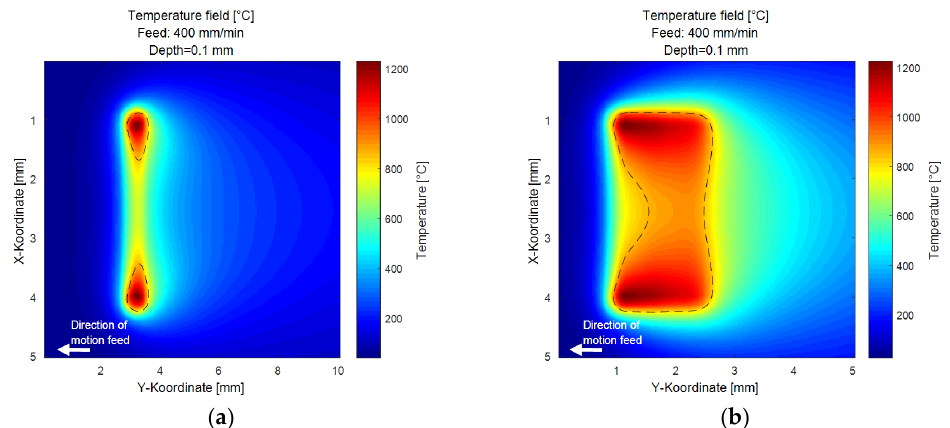
Figure 3. Simulated temperature field of a harmonic oscillating scanner ( a ) and the intensity distribution according to Burger ( b ) at 0.1 mm in AISI